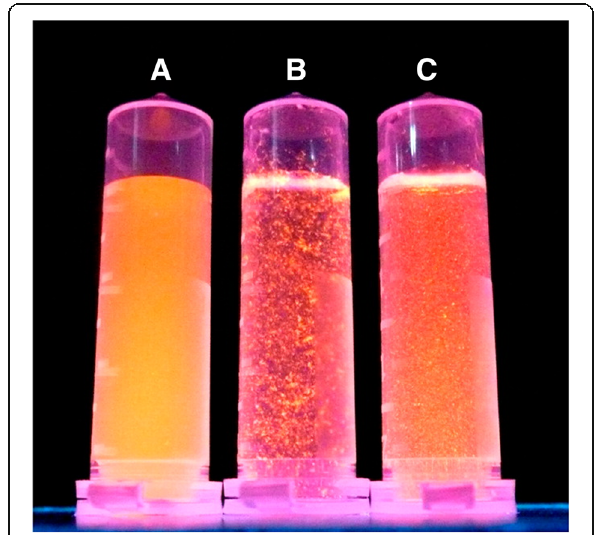
Fig.4 a Fluorescence intensity of MUA-AuNCs in the absence of 170 μ M Hg 2+ . b Agglomeration of Hg 2+ with COOH group of MUA- AuNCs in the presence of 170 μ M Hg 2+ . c Fluorescence intensity after 10 mM cysteine had been added to the sample in B